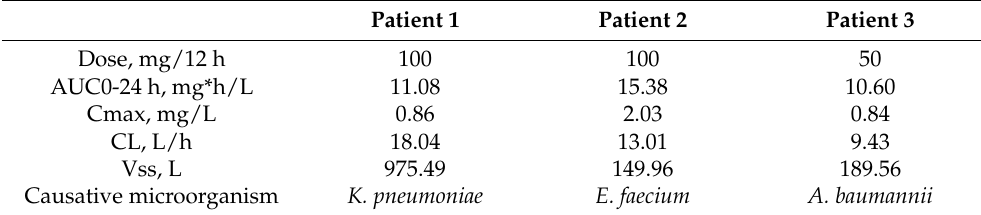
Figure 5. Tigecycline pharmacokinetics in critically ill patients. Each point is the average from triplicate and error bars represented by standard deviation. Table 4. Tigecycline pharmacokinetics in critically ill patients.